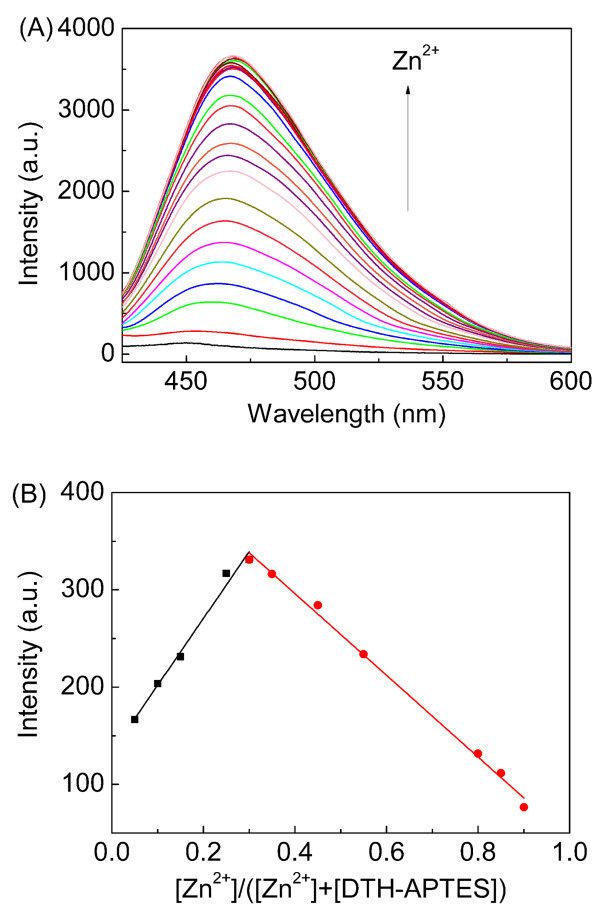
Fluorescence titrations and Job's plot. (A) Fluorescence titrations of DTH-Fe3O4@SiO2 with Zn2+. (B) Job's plot of DTH-APTES with Zn2+. Spectra were recorded every 25 min after adding Zn2+.